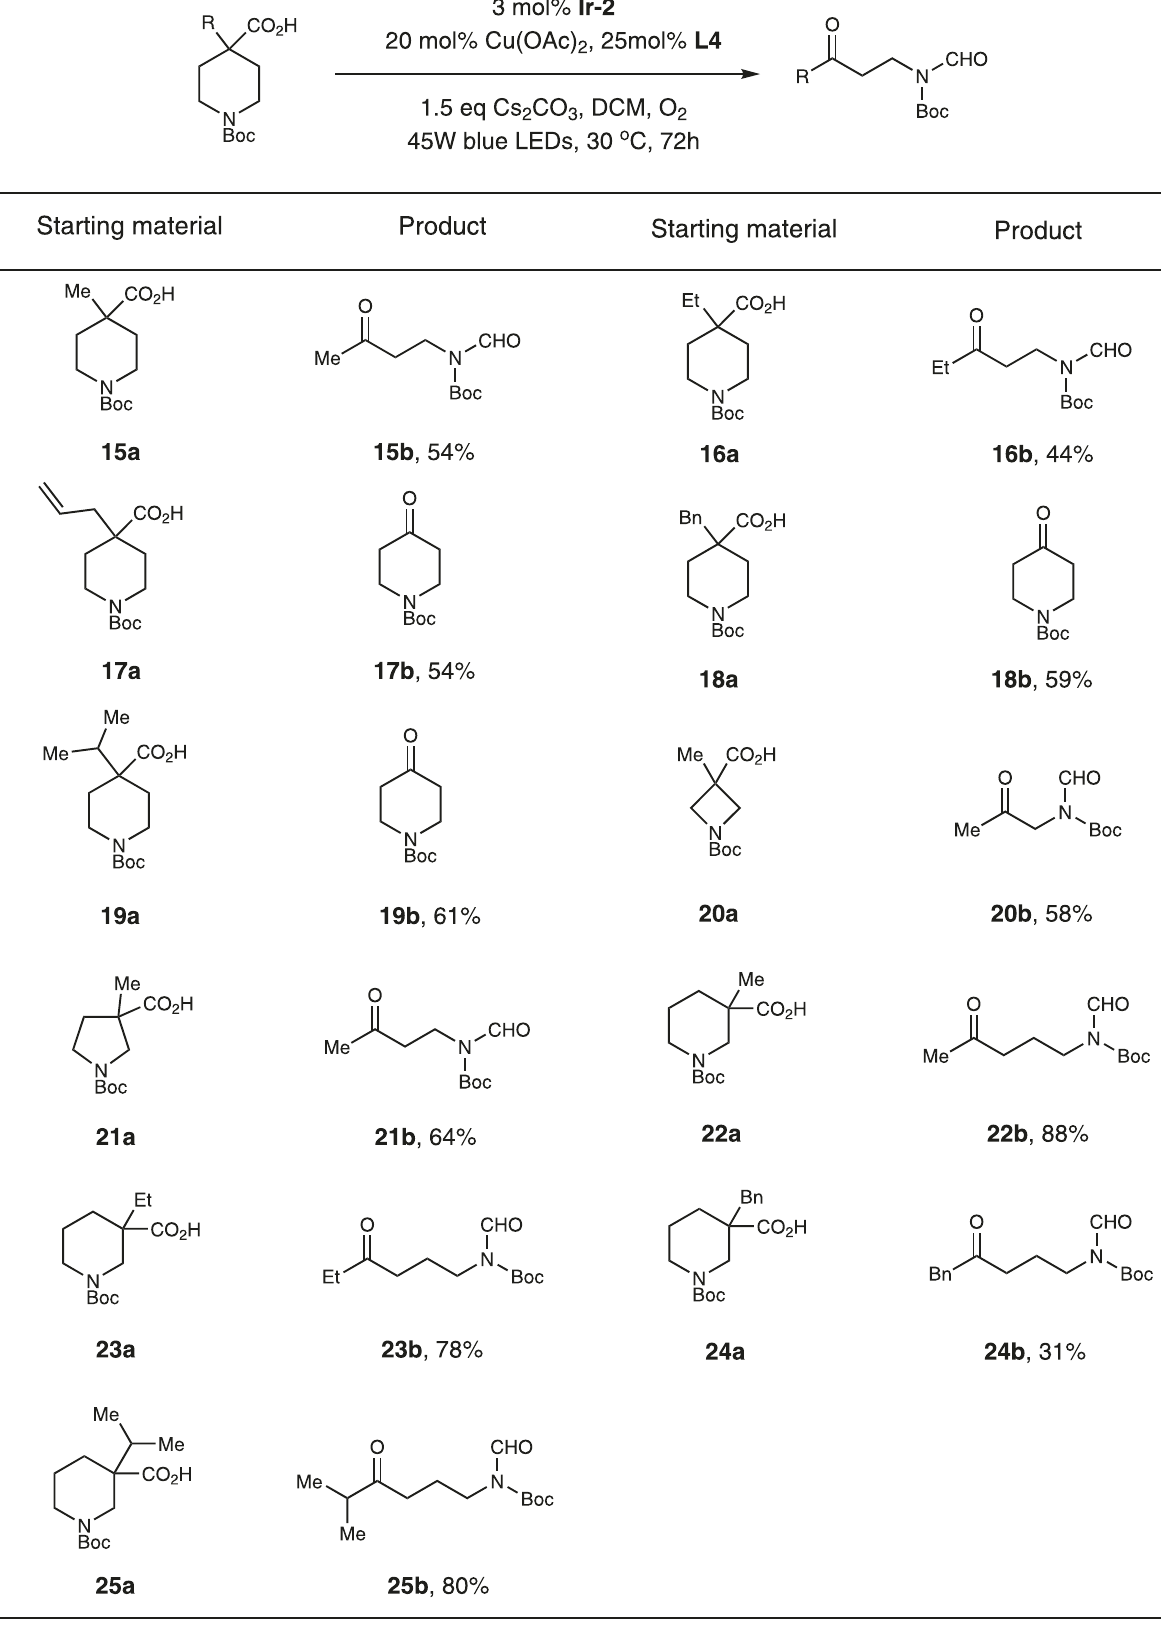
Fig. 3 | Substrate scope of piperidine-4-carboxylic acids. Reaction conditions: substrate (0.5mmol), Ir-2 (0.015mmol), Cu(OAc) 2 (0.1mmol), L4 (0.125mmol), Cs 2 CO 3 (0.75mmol), DCM (10mL), 45W blue LEDs, 30°C,